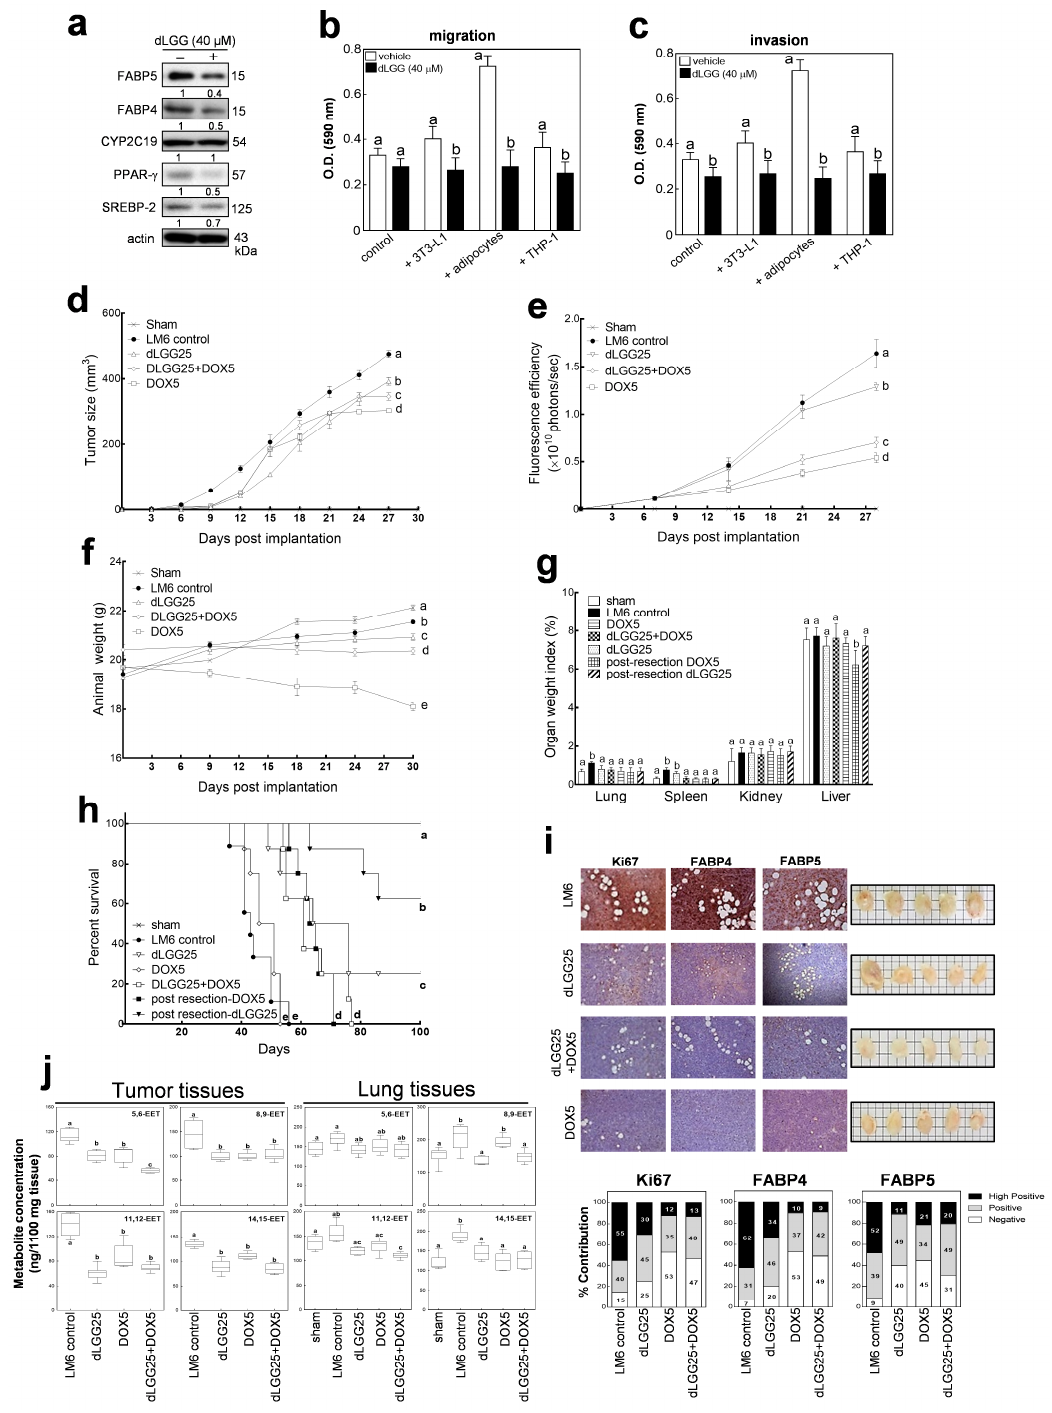
Figure 7. dLGG inhibits EET-FABP-mediated TNBC relapse and metastasis. The effects of dLGG-treatment (40 µ M) on the expression level of ( a ) FABP-EET network proteins and ( b ) migration and ( c ) invasion status of LM6 TNBC cells. The NOD / SCID mice bearing lung-seeking metastatic TNBC tumors (LM6) were treated with vehicle, doxorubicin (DOX5 5 mg / kg daily i.p.), dLGG (dLGG25 25 mg / kg, daily o.p.), and a compound-drug combination of dox and dLGG (DOX5 + dLGG25). ( d ) Tumor size, ( e ) whole body fluorescence, and ( f ) animal and ( g ) tumor and tissue weight were monitored prior to tumor resection. ( h ) Tumors were resected when they reached 500 mm 3 and Ki67, FABP4, and FABP5 expressions were analyzed by IHC and quantified using IHC profiler. ( i ) Survival was monitored